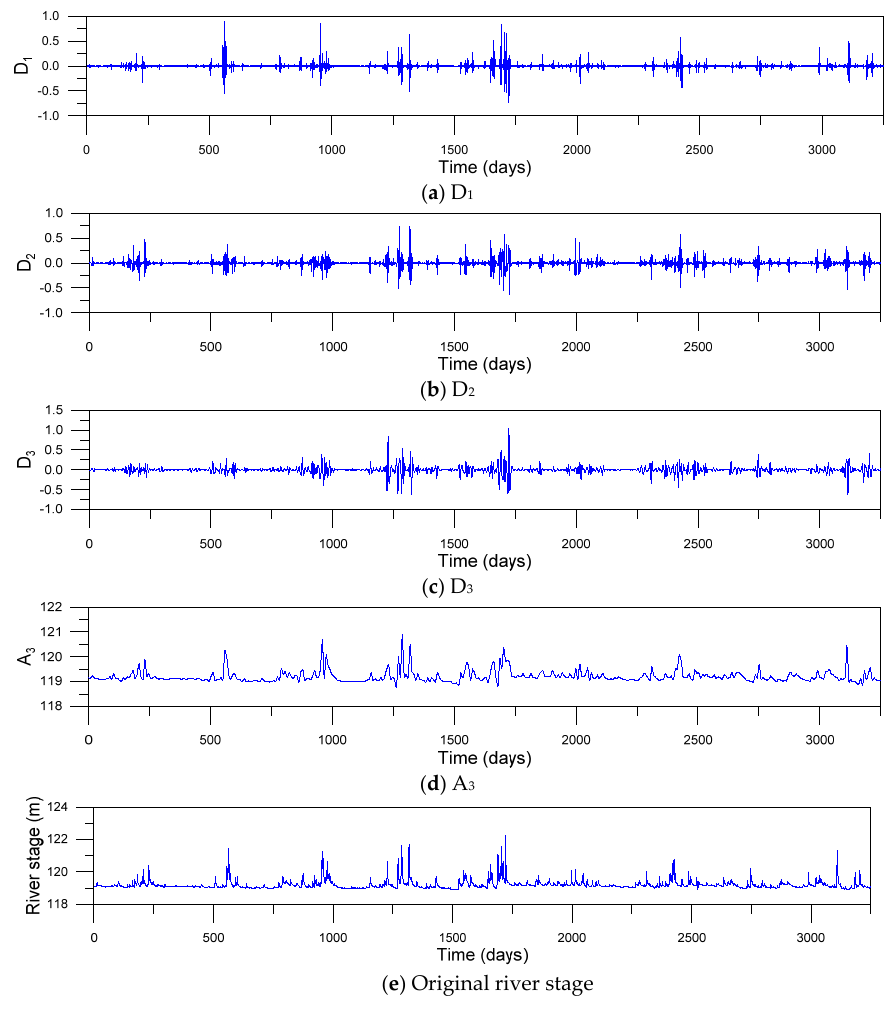
Figure 7. Sub-time series ( a – d ) decomposed by DWT and original river stage time series ( e ) at the Songcheon gauging station.